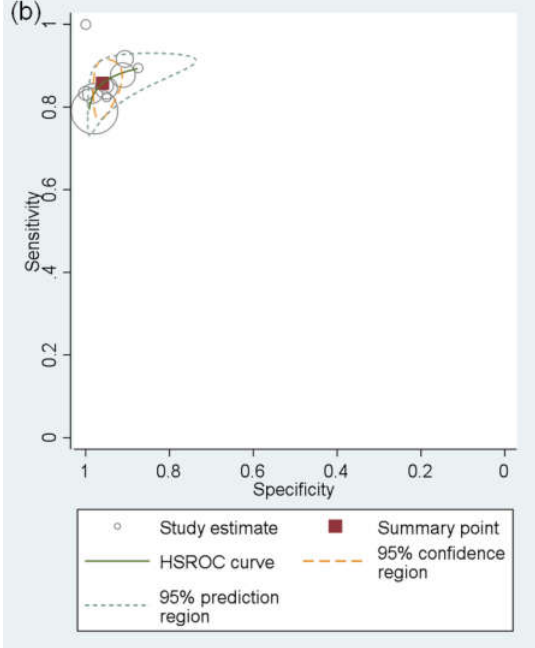
Figure 2. Coupled forest plots and HSROC curve for surveillance AMRI. ( a ) Coupled forest plots of surveillance AMRI for detecting any-stage HCC. ( b ) HSROC curve for the diagnostic accuracy of surveillance AMRI for detecting any-stage HCC. HSROC, Hierarchical Summary Receiver Operating Characteristics; AMRI, abbreviated magnetic resonance imaging; HCC, hepatocellular carcinoma.